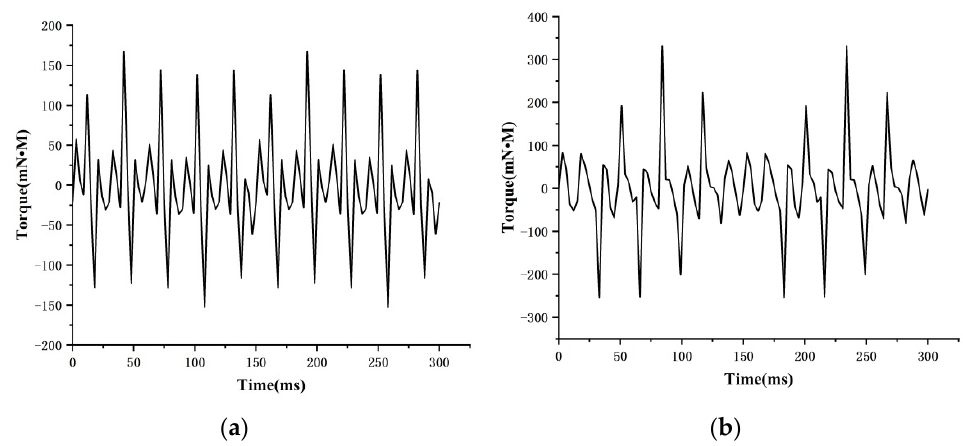
Figure 9. Alveolar torque analysis: ( a ) 6 poles and 15 slots, and ( b ) 6 poles and 18 slots.